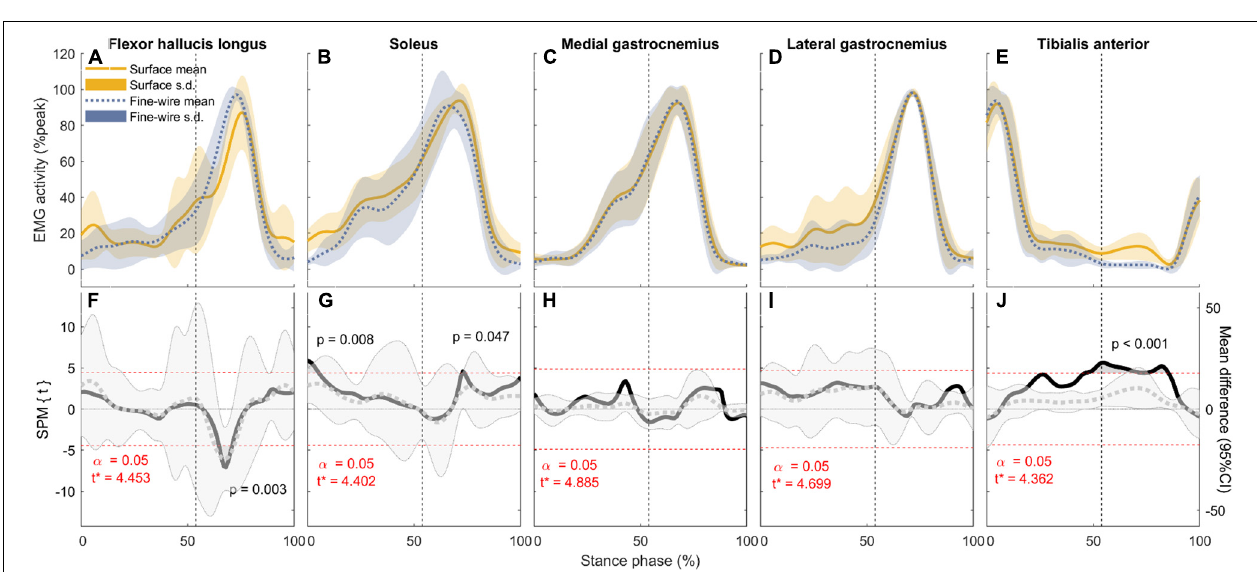
FIGURE 4 | Electromyography (EMG) activity (mean and standard deviation) of each muscle ( A–E , normalised to peak activity in preferred speed walking, %peak) and the corresponding comparisons between surface and intramuscular EMG recordings (F–J) in the stance phase of preferred speed walking (1.43 ± 0.19 m s − 1 ). Vertical dotted lines represent the beginning of push-off. Panels (F–J) : SPM{ t } statistics for two-tailed t -tests (solid black lines, left y -axis), and mean difference with 95% confidence intervals (grey dotted lines with shaded areas). Dashed red lines are critical thresholds ( t ∗ ) calculated for α significance level defining supra-threshold clusters for SPM{ t } trajectories. P -values were calculated for each supra-threshold cluster.